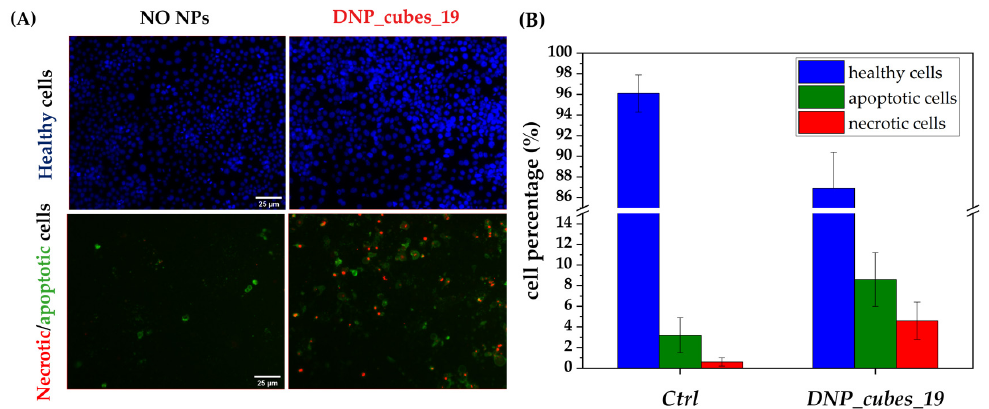
Figure 14. ( A ) Fluorescent images of FaDu cells 24 h after exposure to AMF (304 kHz, 16 kA · m − 1 ) with and without DNP_cubes_19 (incubated for 24 h at 100 µg/mL). ( B ) Corresponding percentage of healthy, apoptotic, and necrotic cells for both cell conditions.